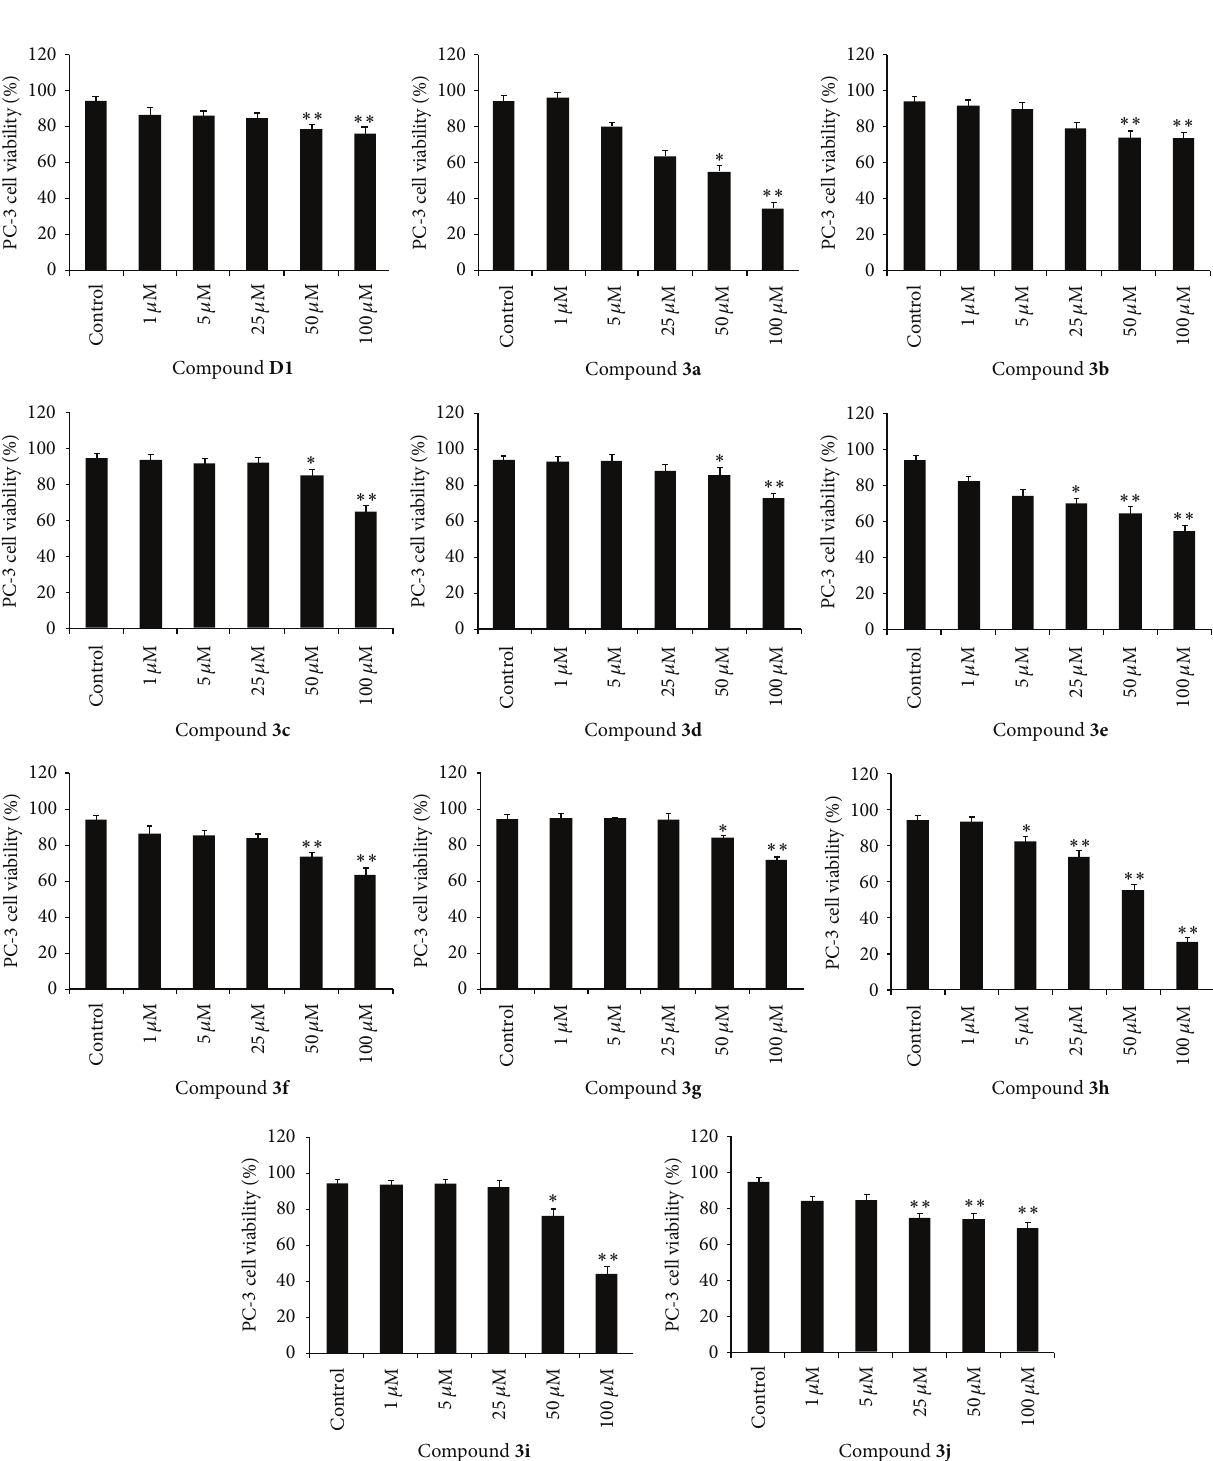
Figure 2: The relative cell viability (%) of PC-3 cells following the exposure of various concentrations of all the compounds ( D1 and 3a – j ) and untreated control cell for 24 h ( ∗ 𝑝 < 0.05 ; ∗∗ 𝑝 < 0.001